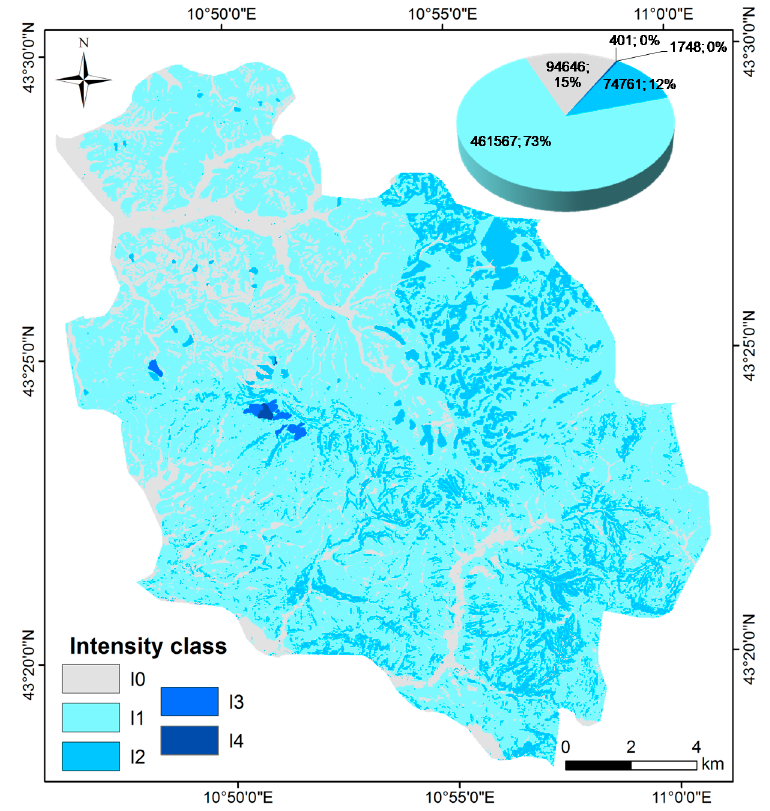
Figure 7. Intensity map (I f ) of ground movements improved with PSI Sentinel-1 data. The pie chart shows number of pixels and related percentage for each Intensity class: The 0% percentages of Intensity classes I3 and I4 actually correspond to decimal values 0.001 and 0.003, respectively.